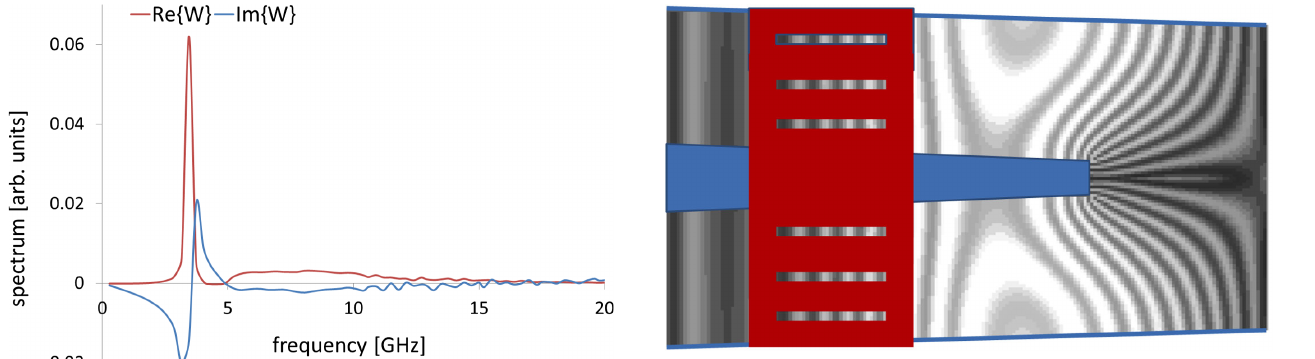
FIG. 12. Real (red line) and imagery (blue line) parts of the wakefield potential spectrum in the IR model 3.